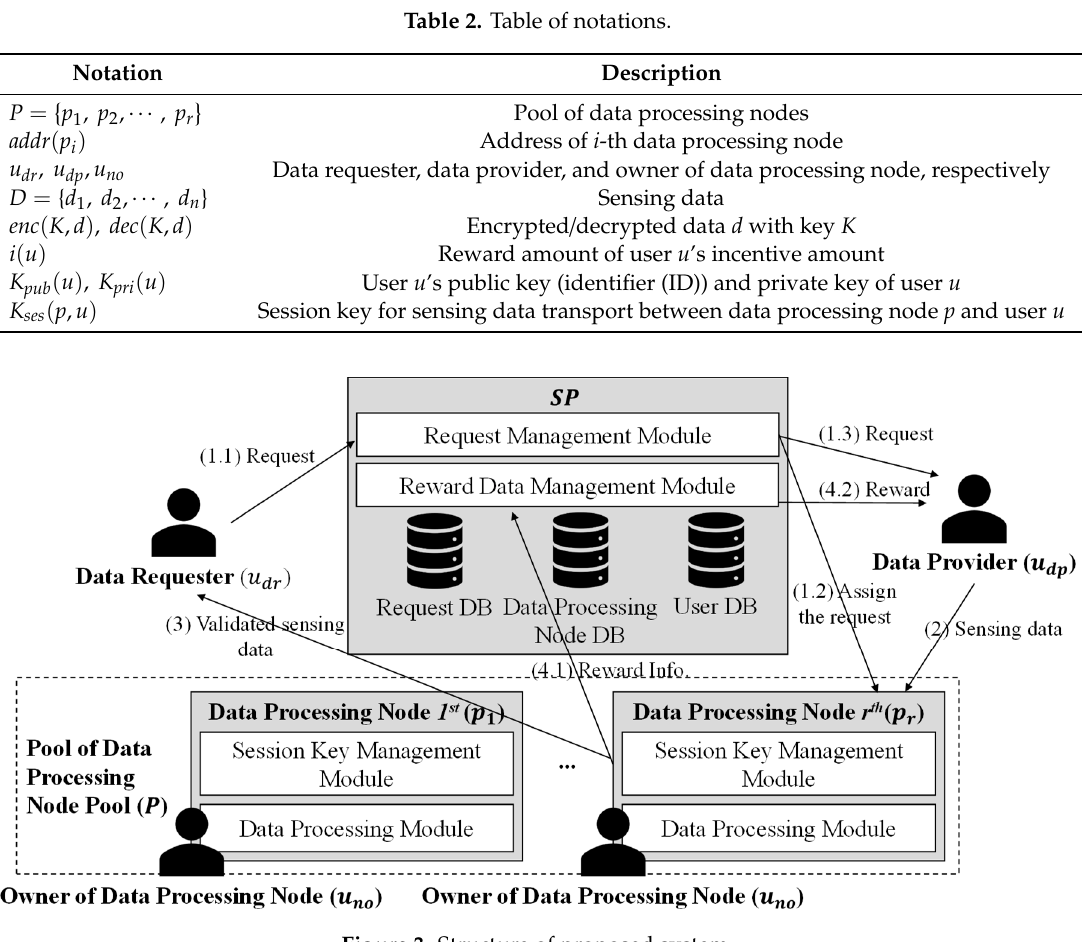
Table 2. Table of notations.